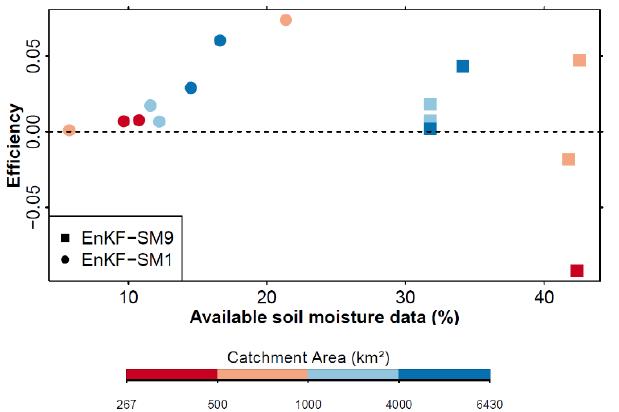
Figure A2. Relationship between the efficiency index and available soil moisture with the Q nor time series.